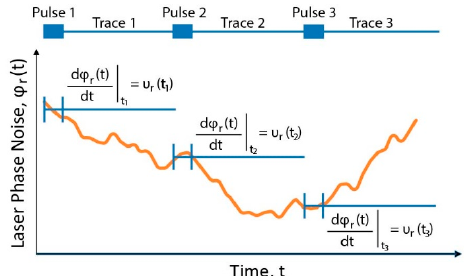
Figure 9. E ff ect of random laser phase noise ϕ r ( t ) over the trace length. In CP- Φ OTDR (blue line), Figure 9. Effect of random laser phase noise ( ) t ϕ over the trace length. In CP- Φ OTDR (blue line), r the shot-to-shot frequency drift of the laser ( υ r ( t i ) = ( 1/2 π ) · ∂ϕ r ( t i ) / ∂ t ) induces a constant perturbation the shot-to-shot frequency drift of the laser ( ( ) (1/ 2 ) ( ) t t t υ π ϕ= ⋅∂ ∂ ) induces a constant perturbation r i r i ( ∆ ε r ∝ υ r ( t i ) ) along the whole fibre trace for each pulse / trace. In coherent-detection Φ OTDR schemes ( ( ) t ε υΔ ∝ ) along the whole fibre trace for each pulse/trace. In coherent-detection Φ OTDR schemes r r i (orange line), the ϕ r ( t ) is randomly added to all points of the optical (orange line), the ( ) t ϕ is randomly added to all points of the optical trace. r